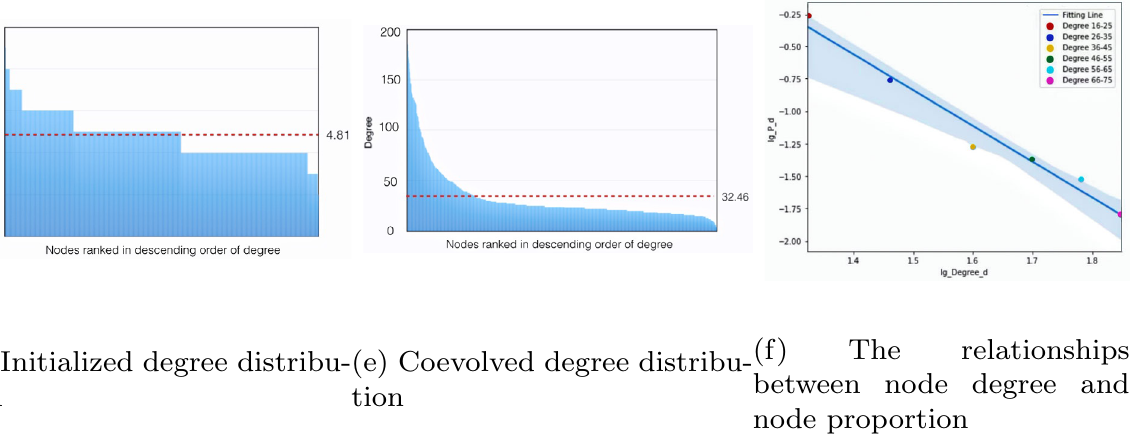
Fig. 3 Structural